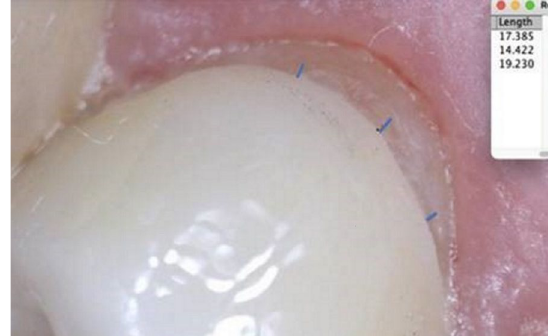
Fig. 9 Image of palatal side showing the margin analysis by the imageJ software in three